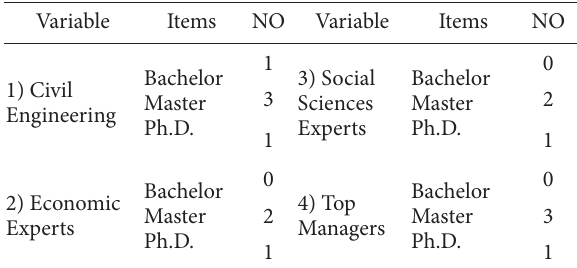
Table 2. Background information of experts